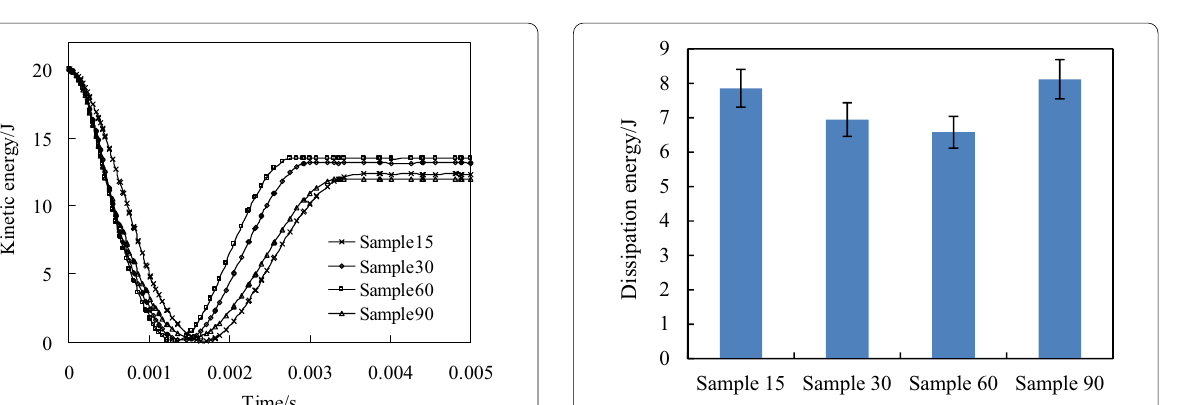
Fig. 12 Dissipated energy of the four different models when the impact energy is 20